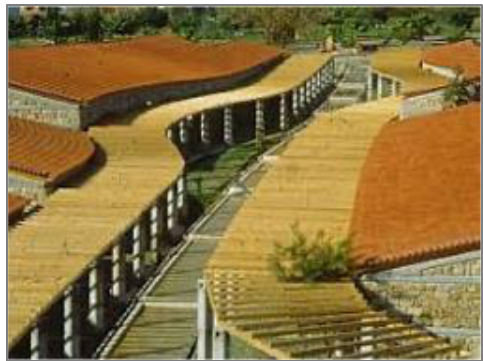
Figure 17 Cengiz Bektaş, Olbia Sosyal Özek project, Akdeniz University (URL-9)